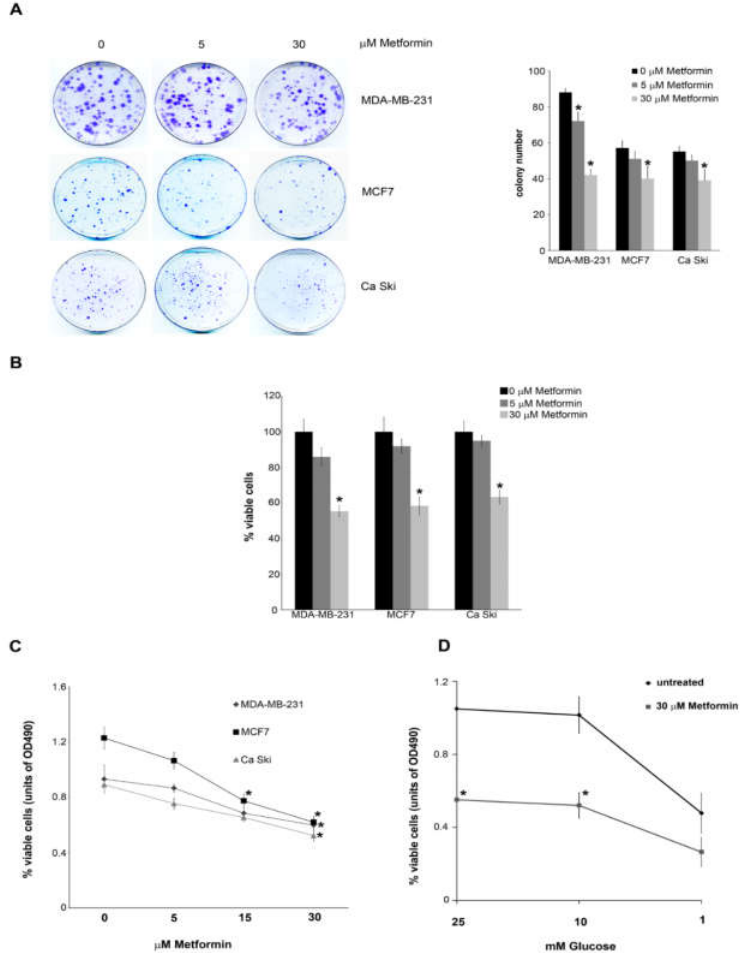
Figure 1. Low doses of metformin reduce colony formation and cell viability in tumour cell lines; ( A ) MDA-MB-231, MCF7 and Ca Ski cells were seeded at low density (2 × 10 3 ) in the presence or absence of micromolar doses of metformin. After 20 days dishes were washed in PBS and cells fixed and stained. Number of colonies were counted the following day and the results graphed in the right side of the figure; ( B ) MDA-MB-231, MCF7 and Ca Ski cells were either left untreated or treated with different doses of metformin. Cell viability was measured by trypan blue exclusion as indicated under Material and Methods; ( C ) MDA-MB-231, MCF7 and Ca Ski cells were either left untreated or treated with different doses of metformin. cell growth was measured by CellTiter 96 ® aqueous solution cell proliferation assay as indicated under Material and Methods; ( D ) MDA-MB-231 cells were grown in growth medium containing different glucose concentration in the presence or absence of 30 µ M metformin. Cell growth was measured by CellTiter 96 ® aqueous solution cell proliferation assay as indicated under Material and Methods. All experiments in this figure were repeated three times. * Significantly different from control untreated